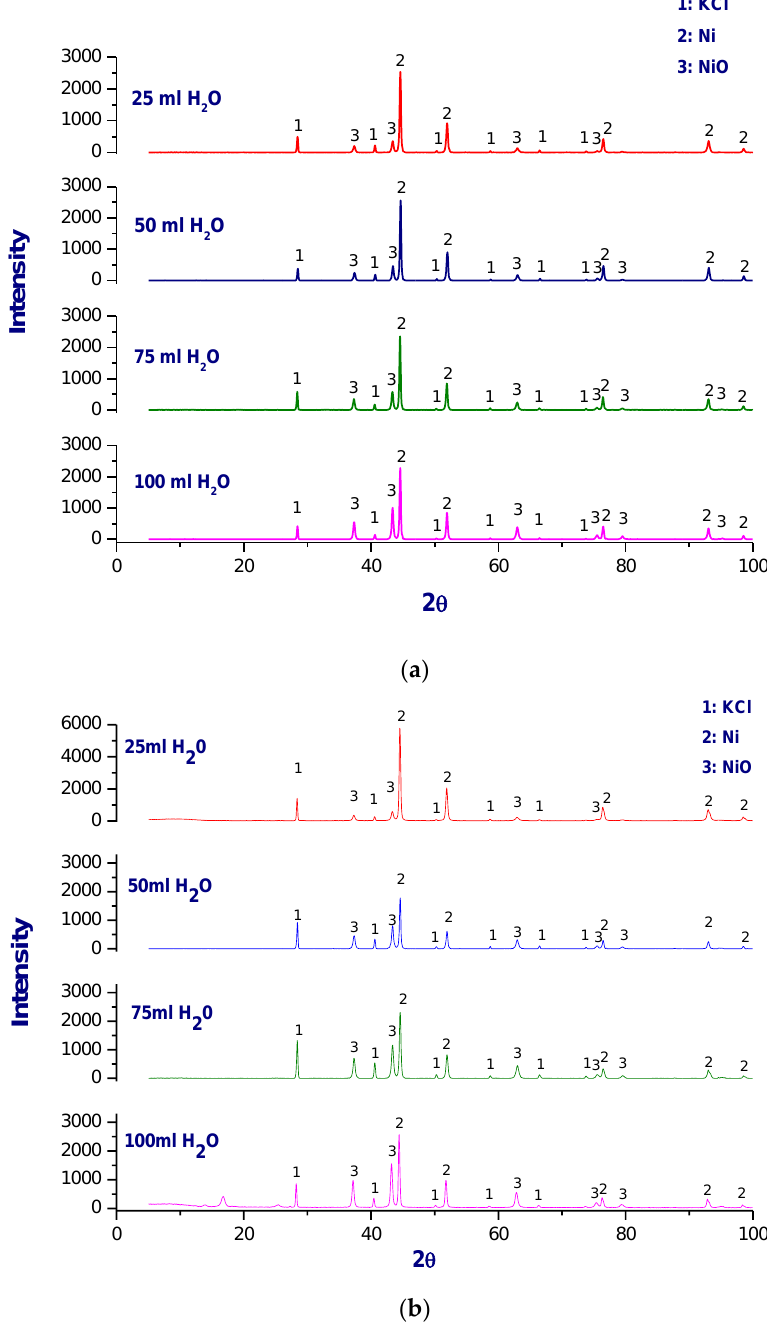
Figure 2. XRD patterns from the solution combustion synthesis (SCS) derived materials on the basis of the initial mixture of 66.7% Ni(NO 3 ) 2 · 6H 2 O and 33.3% glycine with different amounts of water added in the initial solution ( a ) with and ( b ) without heated stirring.